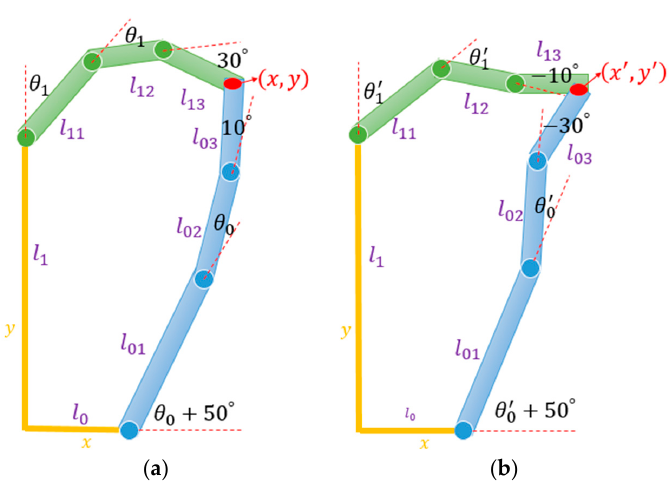
Figure 12. Hyperextension mechanism: ( a ) initial contact state; ( b ) full hyperextension state.